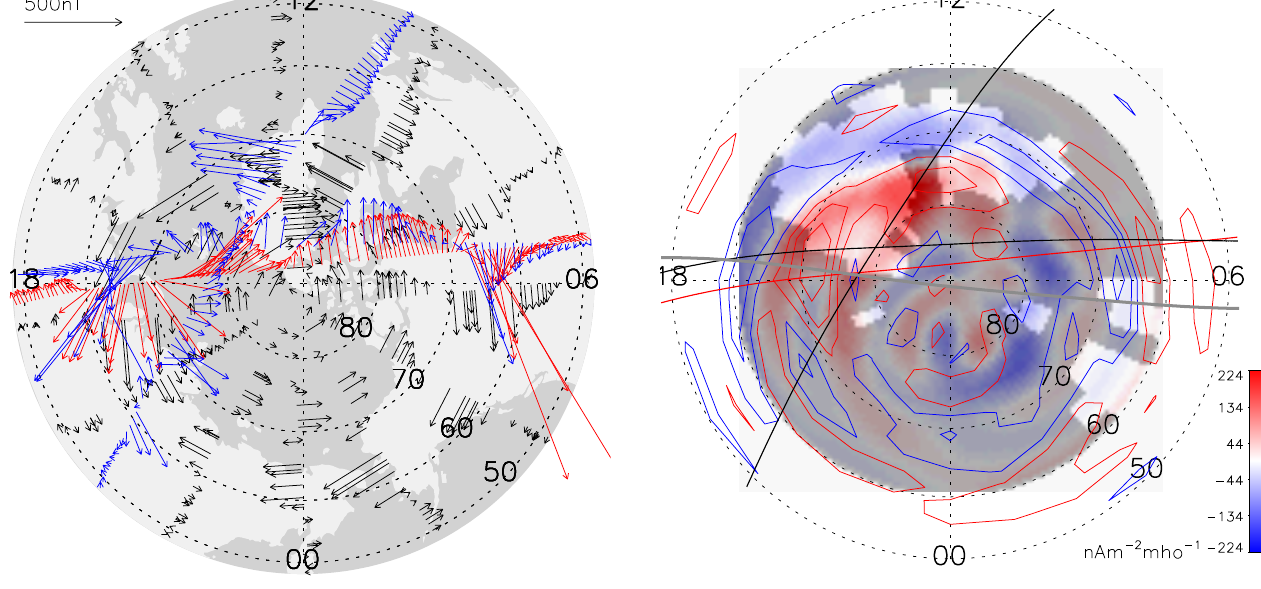
Fig. 12. Cross-track component of the Iridium 4 b data (black) for 3 October 2002, 13:00–14:00 UT. The red track represents full vector 4 b observations from the Oersted satellite pass for 13:38–14:08 UT while the two blue tracks are DMSP satellites F13 (dusk-dawn) and F15 for the intervals 13:13–13:44 UT and 13:34– 14:05 UT, respectively.